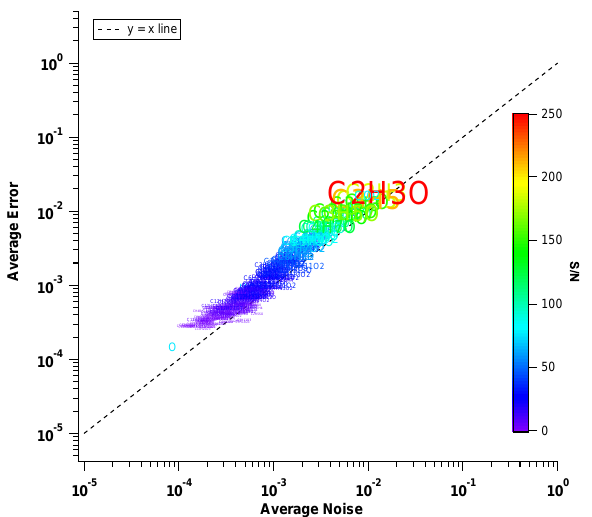
Fig. A2. Average error vs. the average noise for each ion is plot- ted along with the y = x line. The marker is labeled by the ion it represents and is colored and sized by the S/N ratio of that ion. If the marker lies directly on the y = x line, this means the calculated errors have captured the noise in the ion signal, which is critical for PMF analysis.